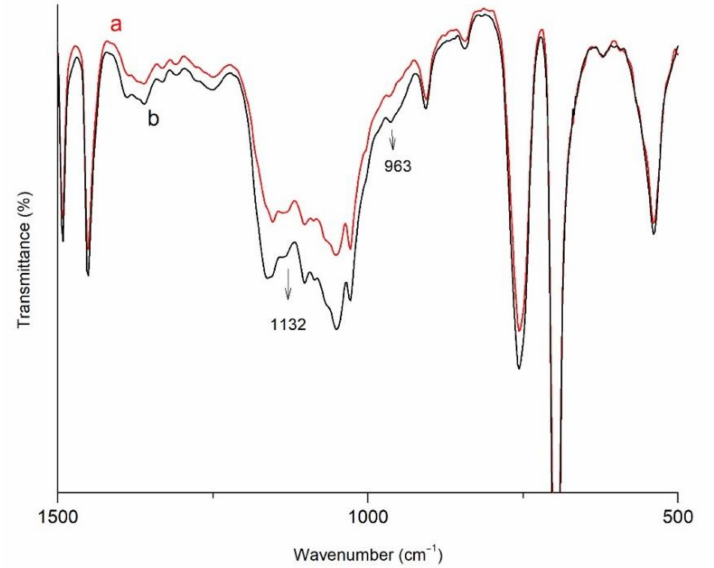
Figure 8. FTIR spectra of ( a ) C-OBMI-St-AGC-APTES and ( b )